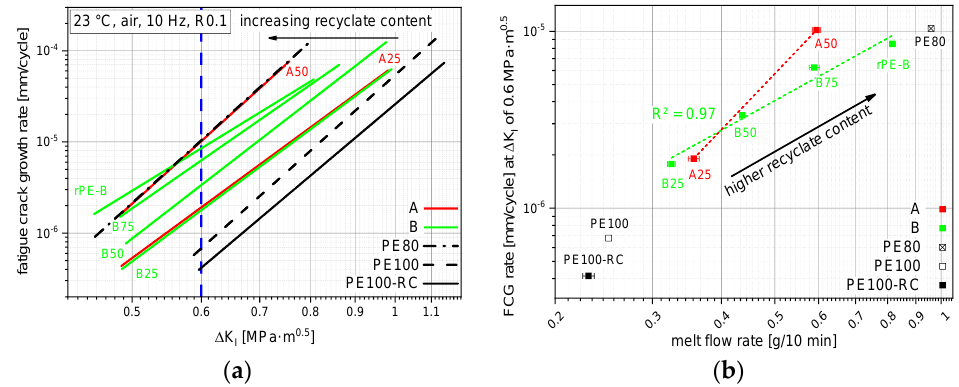
Figure 8. FCG kinetic curves of all tested materials ( a ) with a horizontal red line depicting the predefined FCG range to obtain stress intensity factor ranges for a correlation with the MFR values ( b ). The horizontal bars show the sample standard deviation.